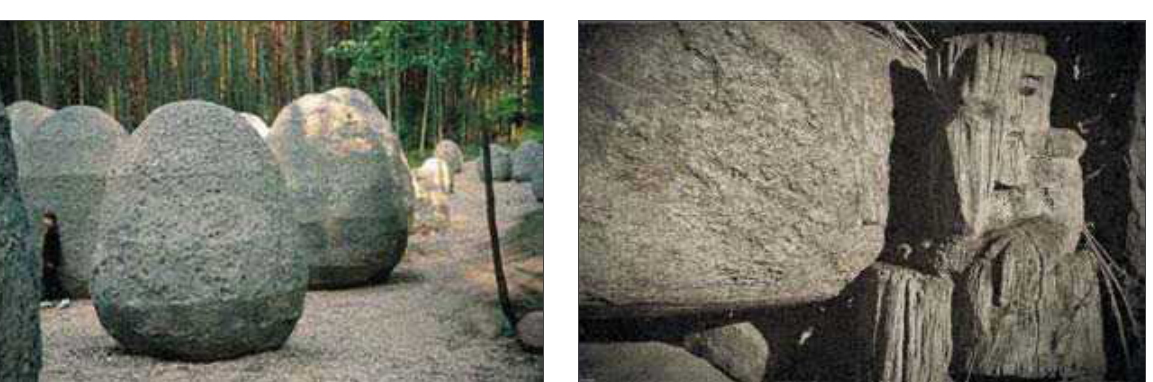
Fig. 5. artificially engaged professional attempts to create "europa" park of sculptures